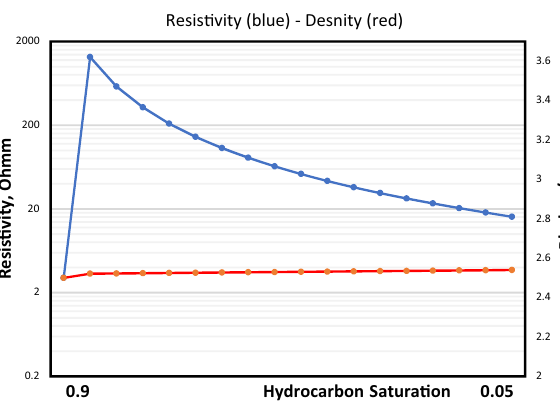
Fig. 4 Density–resistivity overlay, V